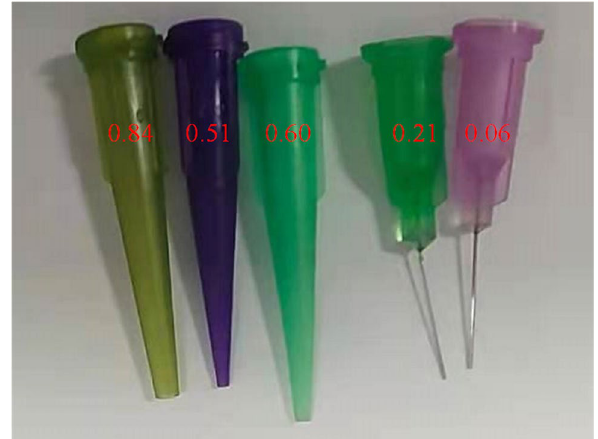
Figure 1. Specification of droplet generator